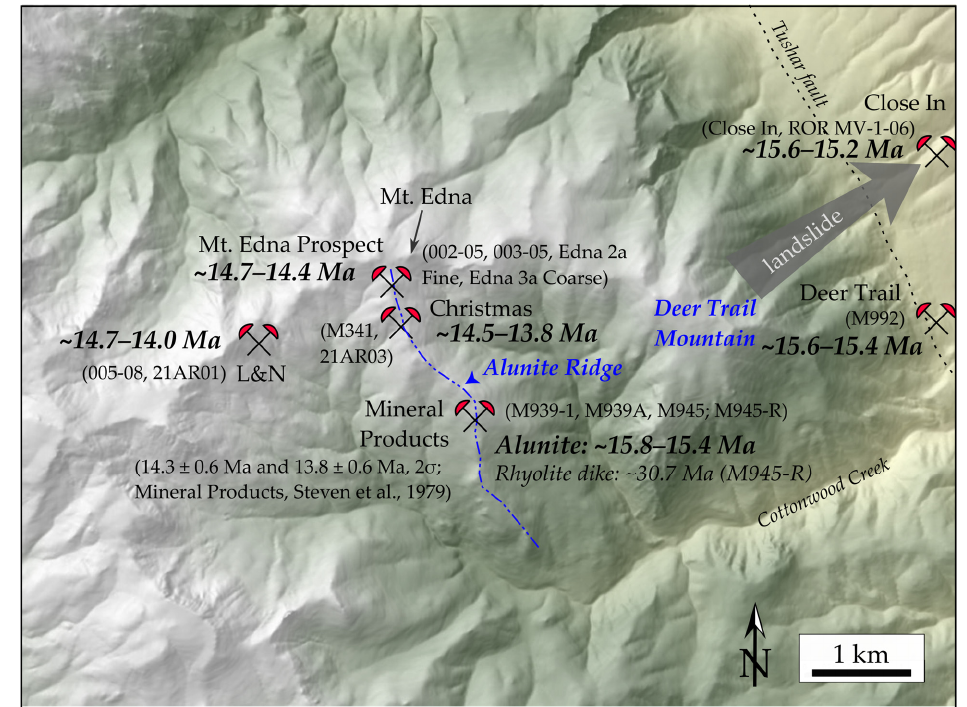
Figure 8. Summary of the ranges of 40 Ar/ 39 Ar dates for magmatic-steam alunite and sericite from the mines and prospects sampled here. Two K/Ar dates published by Steven et al. [15] for samples of magmatic-steam alunite from the upper Mineral Products mine are listed as well (with internal uncertainties only; see Section 2.1 and Table S1 for external uncertainties). The location shown for the Deer Trail mine marks the portal; the workings extend ca. 3200 m to the west beneath Deer Trail Mountain [14]. The younger episode of magmatic degassing is clearly recorded at the Christmas and L&N mines and the Mt. Edna prospect. Given that 10 of the 12 aliquots (all M341 aliquots excluding A2 and D2) from seven alunite bands in the banded slab from the Christmas mine yielded a weighted mean of 13.98 ± 0.12 Ma (Figure 5), we interpret the bands to have completely formed within a period of ca. 250 ka (based on the 95% CI of the weighted